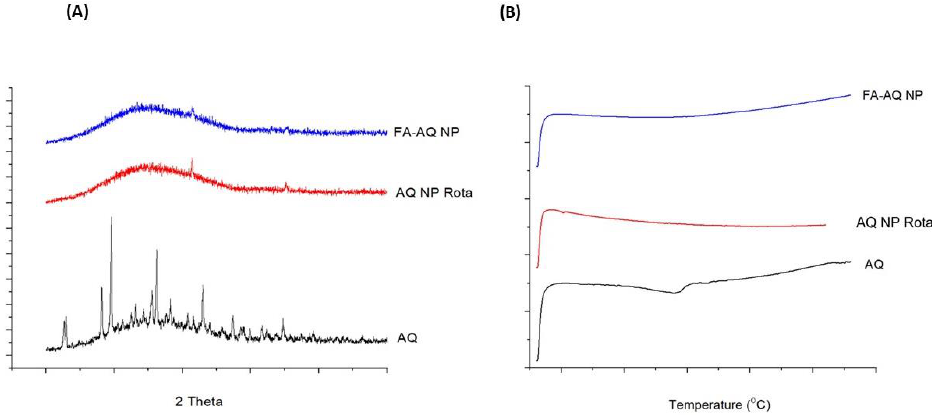
Figure 3. ( A , B ) Solid state characterization studies: ( A ) XRD patterns of AQ, AQ NP Rota, and FA- AQ NP; ( B ) Thermograms of AQ, AQ NP Rota, and FA-AQ NP. FA-AQ NP; ( B ) Thermograms of AQ, AQ NP Rota, and FA-AQ